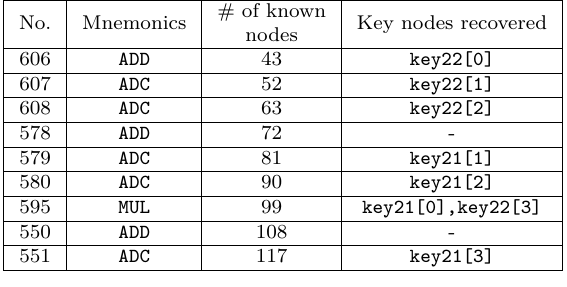
Table 5: Attack on SPECK found by TADA - Each row corresponds to a vulnerable instruction with sequence number “No.” and operation with “Mnemonics” such that after the attack on this instruction, the number of known nodes is given by “# of known nodes” and the key nodes that are retrieved are given by the last